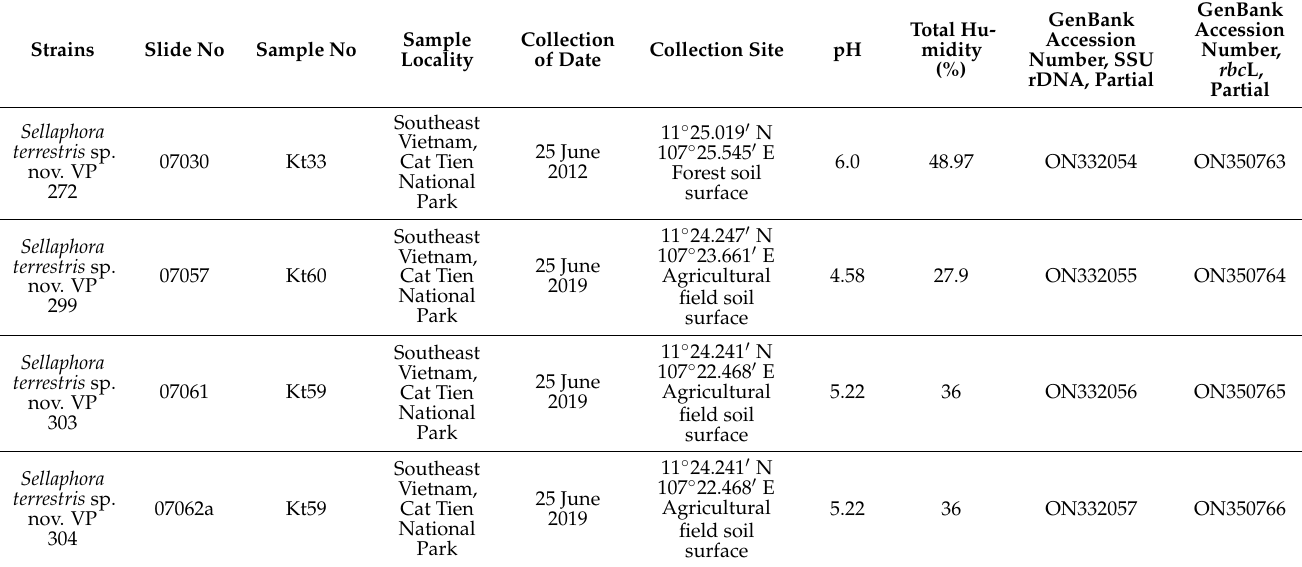
Table 4. List of strains examined in this study, with their GenBank accession numbers. Geographic locality of samples and measured ecological parameters are